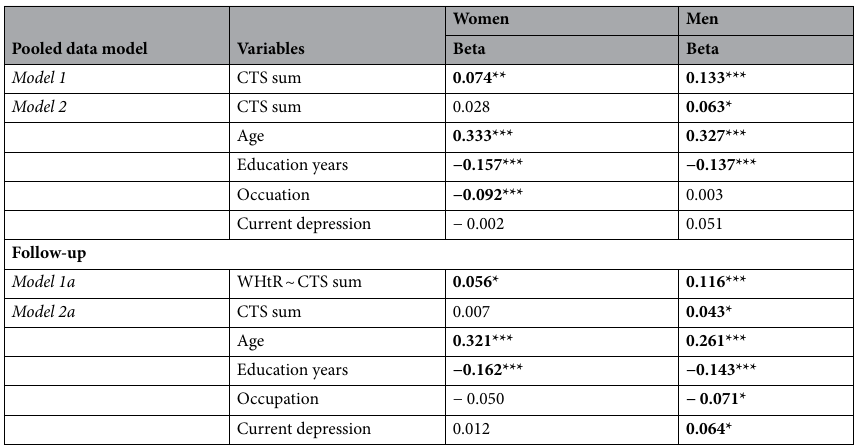
Table 3. Results from the multivariable regression models with body shape as outcome−baseline. Model 1 uses the CTS score as predictor for body shape (WtHR) only. To compare the strength of the effect, model 2 includes known sociodemographic variables predicting an increased WHtR. Follow-up: Concerning the CTS sum score as predictor of the WHtR in men, the strength of the effect was similar to the baseline. However, in women the effect was reversed. Age (increased) and educational years (decreased) are the strongest predictors for changes in body shape. + p < = 0.1, *p < = 0.05, **p < = 0.01, ***p < = 0.001. Statistical significant results are highlighted in